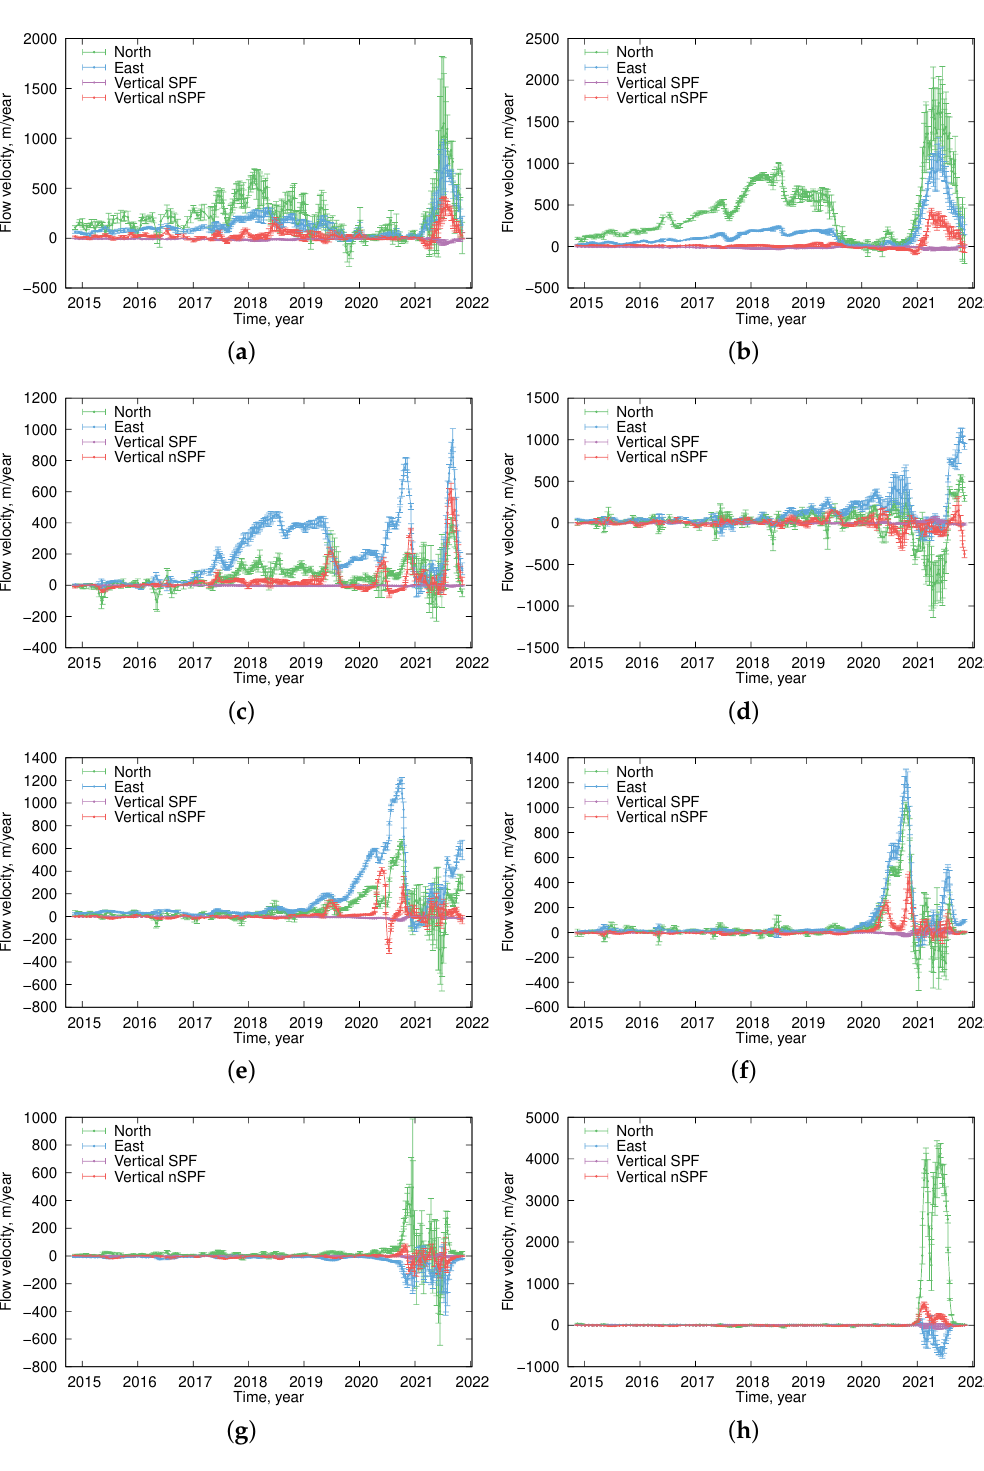
Figure 7. 4D flow velocity time series for ( a ) 5, ( b ) 10, ( c ) 15, ( d ) 20, ( e ) 25, ( f ) 30, ( g ) 35, ( h ) 40 km markers along central flowline of Muldrow